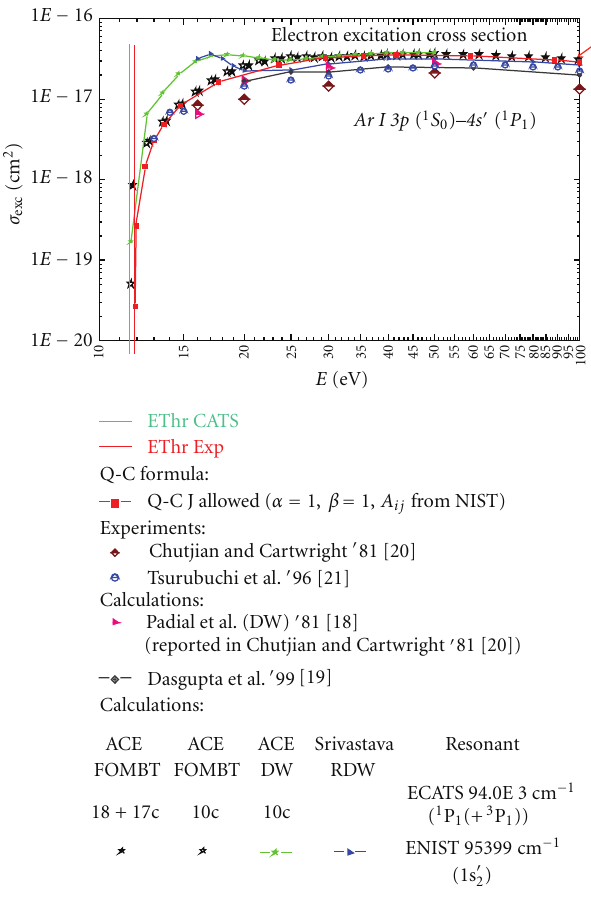
based in the Coulomb approximation, proposed by Bates and Damgaard [5], both in jK and LS coupling